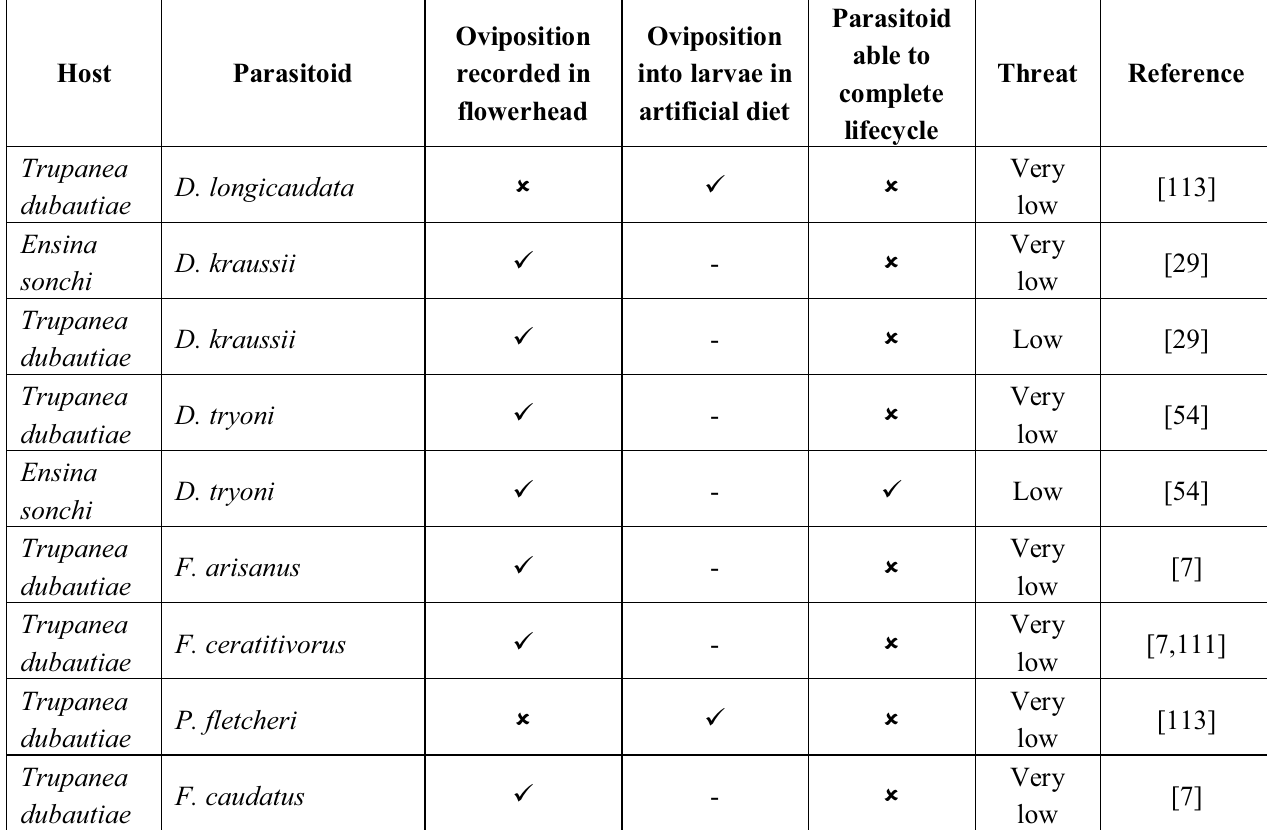
Table 3. Non-target impacts of opiine braconids, Diachasmimorpha , Fopius , and Psyttalia spp., on flower-feeding tephritids. (- indicates no record). Oviposition